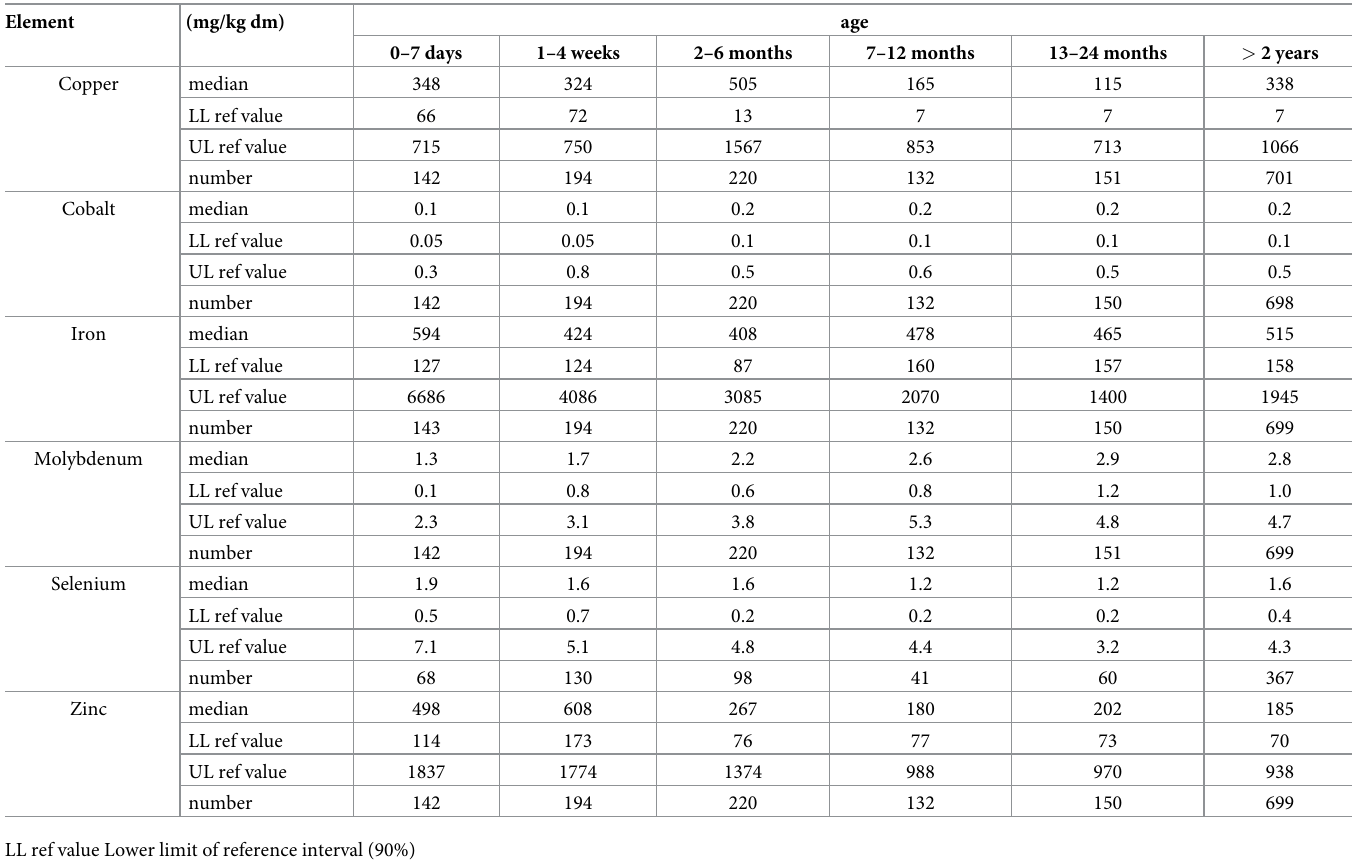
Table 3. Results (median and 90% upper and 90% lower level) of trace elements in bovine livers, depending on age of the animal. Element (mg/kg